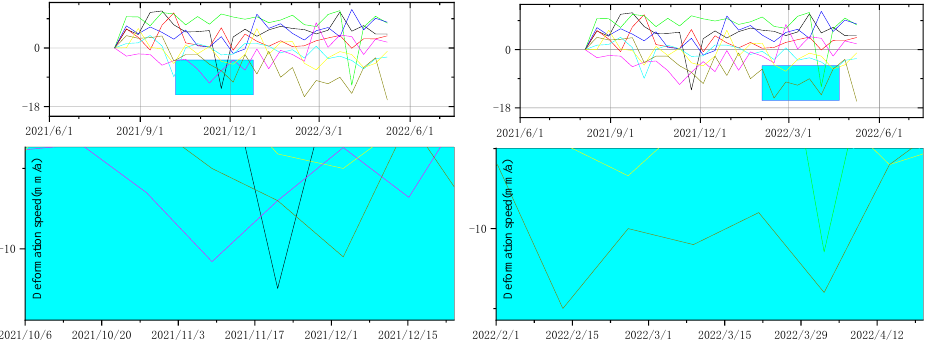
Figure 16. Time sequence analysis of SBAS10-SBAS17 of the monitoring feature points of the southwest section of Haidi Road in the mud area.